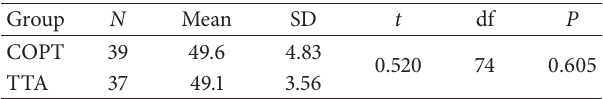
Table 4: Independent-samples 𝑡 -test on critical thinking skills pre- test.